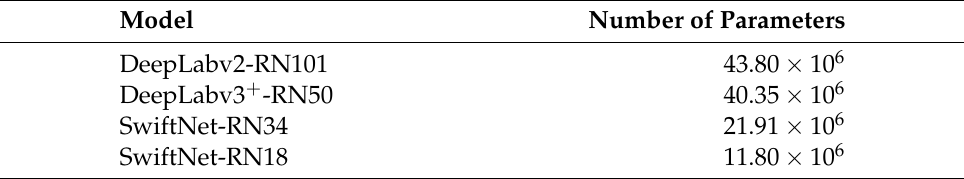
Table A4. Number of model